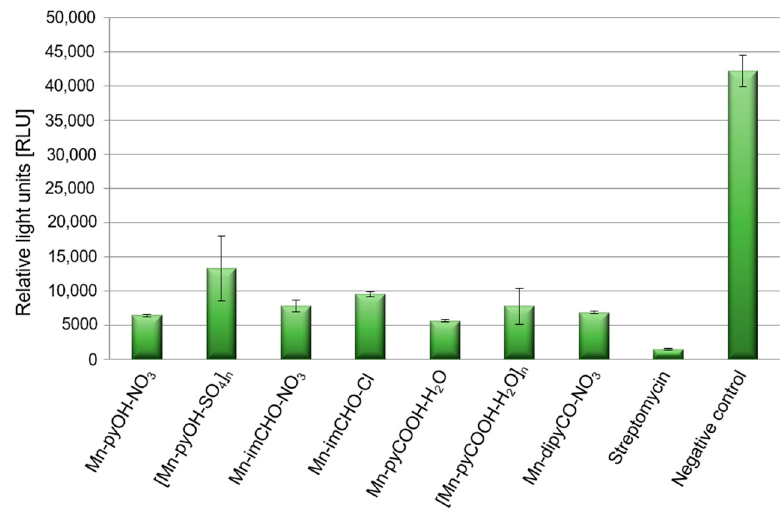
Figure 10. Level of pyoverdine secretion by P. aeruginosa strains after incubation with the manganese complex, and streptomycin as a positive control, with an untreated sample as the negative control.